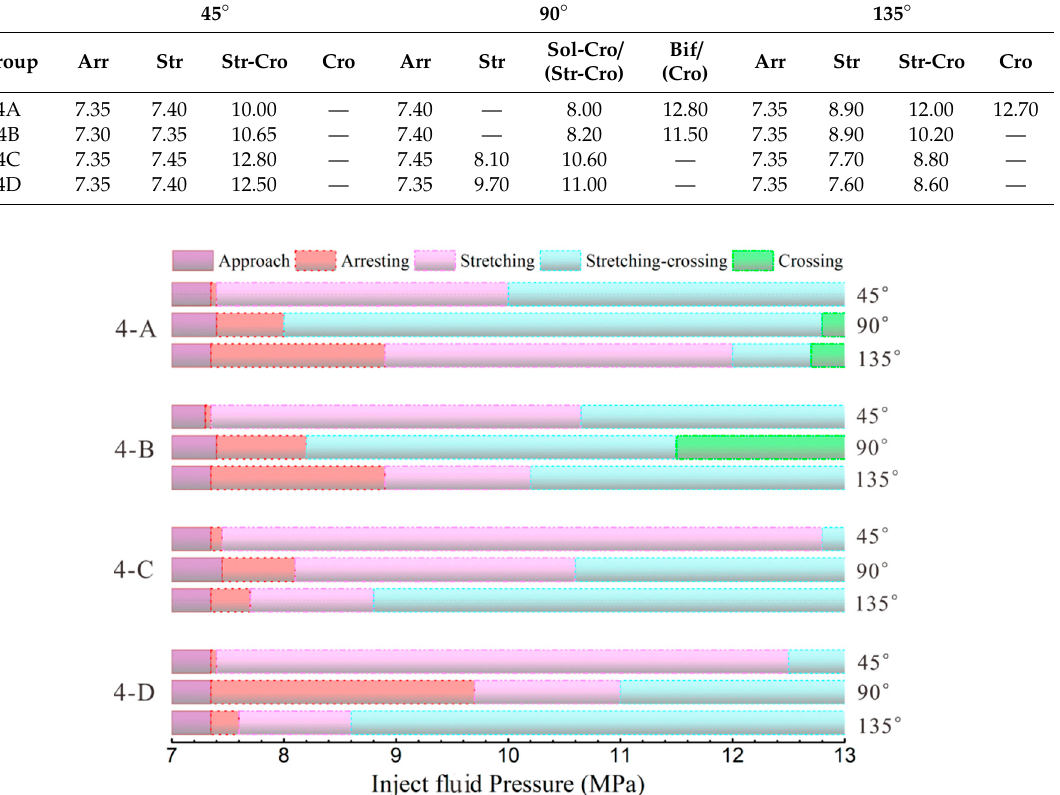
Figure 15. Fluid pressure zones for different interaction modes.